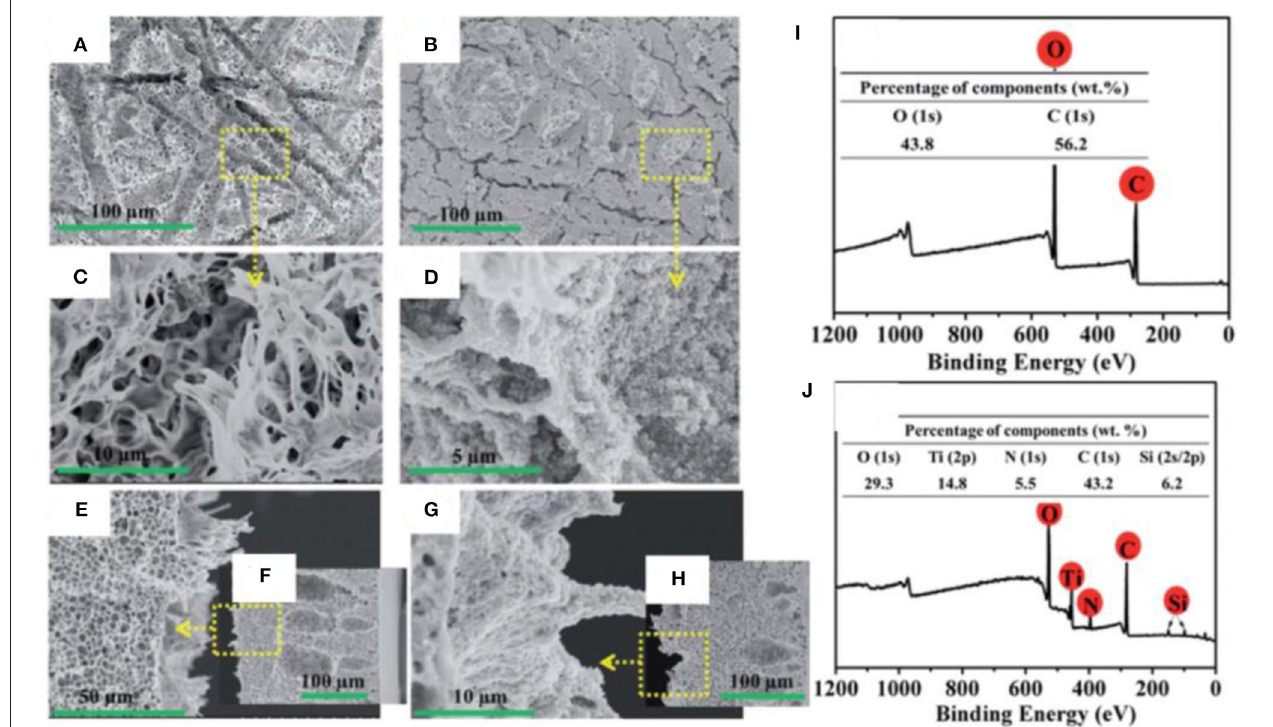
FIGURE 14 | Plan view and cross-sectional SEM images of (A,C,E,F) pristine and (B,D,G,H) TiO 2 -modified membrane. X-ray photoelectron spectroscopy (XPS) of (I) pristine and (J) TiO 2 membranes. With permission from the Royal Society of Chemistry, copyright 2017 (Xiong et al., 2017).